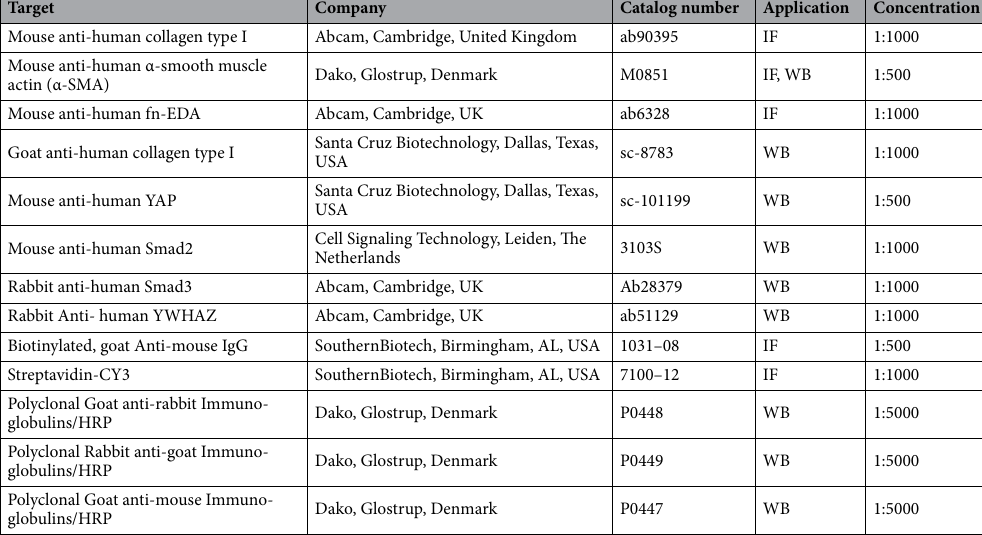
Table 2. Used antibodies in immunofluorescence (IF) and Western blotting (WB).